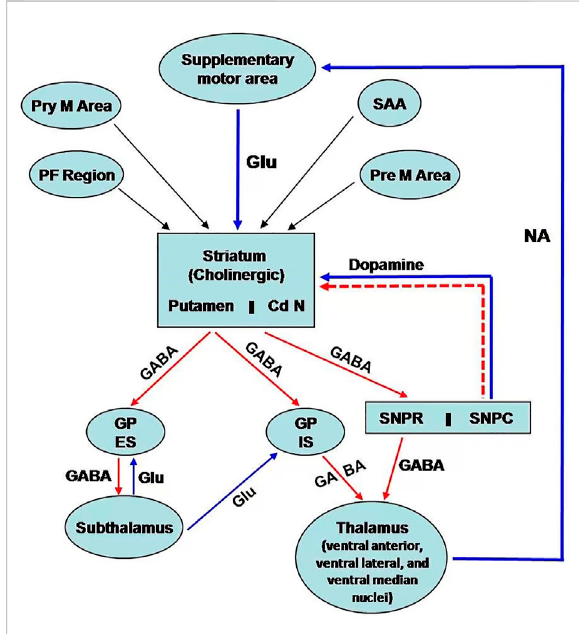
FIGURE 1 Schematic representation of neural connection of the basal ganglia. There are three main pathways: i) nigrostriatal dopaminergic pathway; ii) intrastriatal cholinergic pathway; iii) GABAergic pathway from the striatum to GP and SN. [PF cortex: Prefrontal; Pre M; Premotor; Pry M: Primary motor; SAA: Sensory associated area; Cd N: Caudate nucleus; GP ES: Globus Pallidusexternalsegment;GPIS:Globuspallidusinternalsegment; SNPR:Substantianigraparsreticularis;SNPC:Substantianigrapars compacta;GLU:Glutamatre; GABA:Gamaaminobutyricacid;NA: